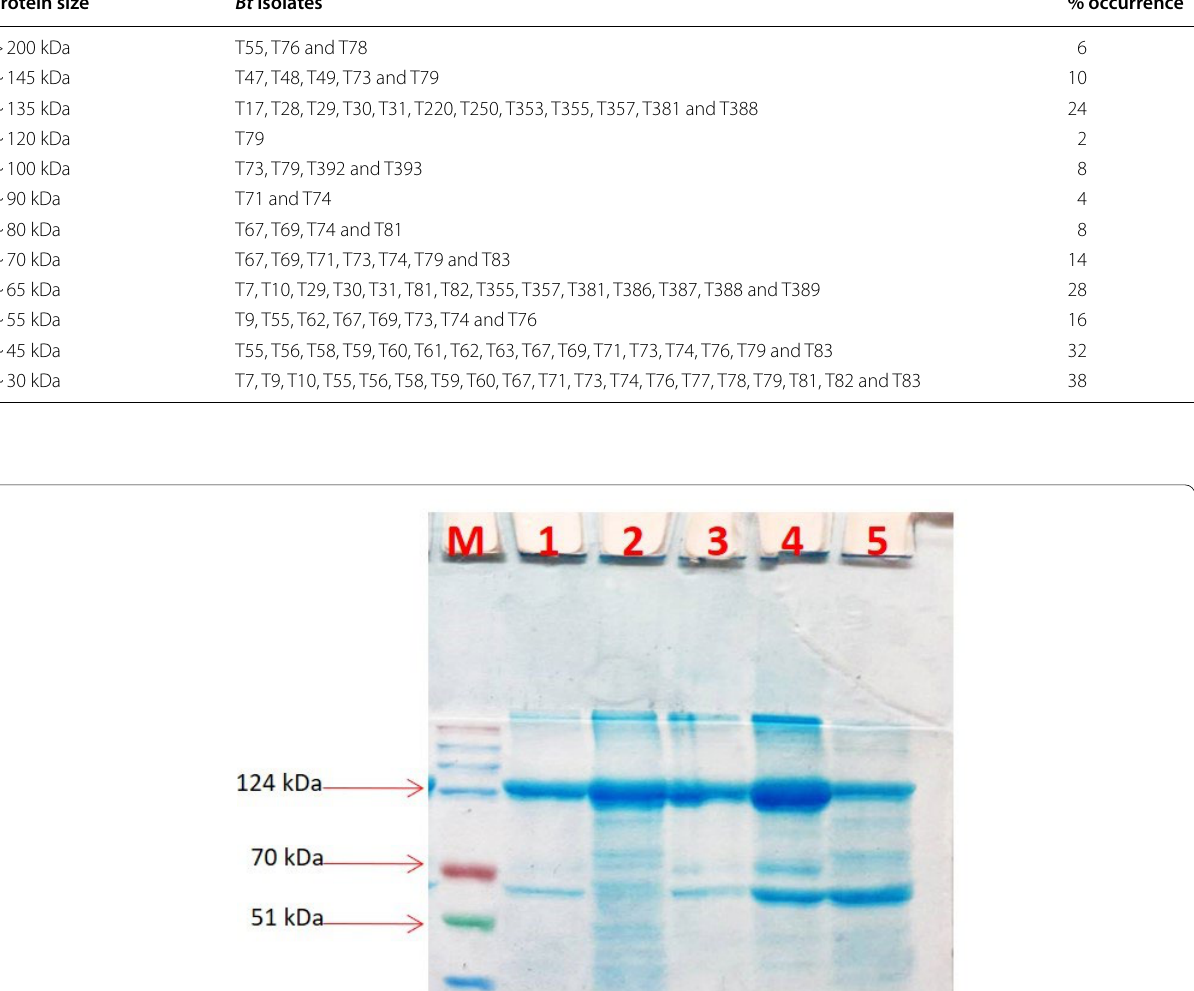
Table 3 Protein profile of indigenous Bt isolates from SDS-PAGE analysis Protein size